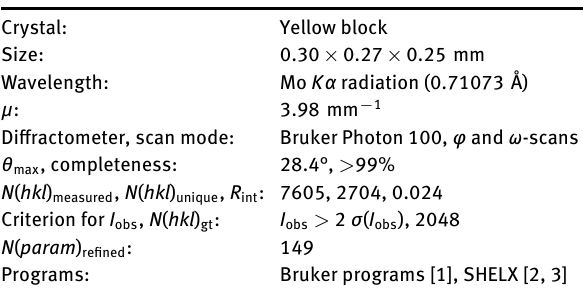
Table 2: Fractional atomic coordinates and isotropic or